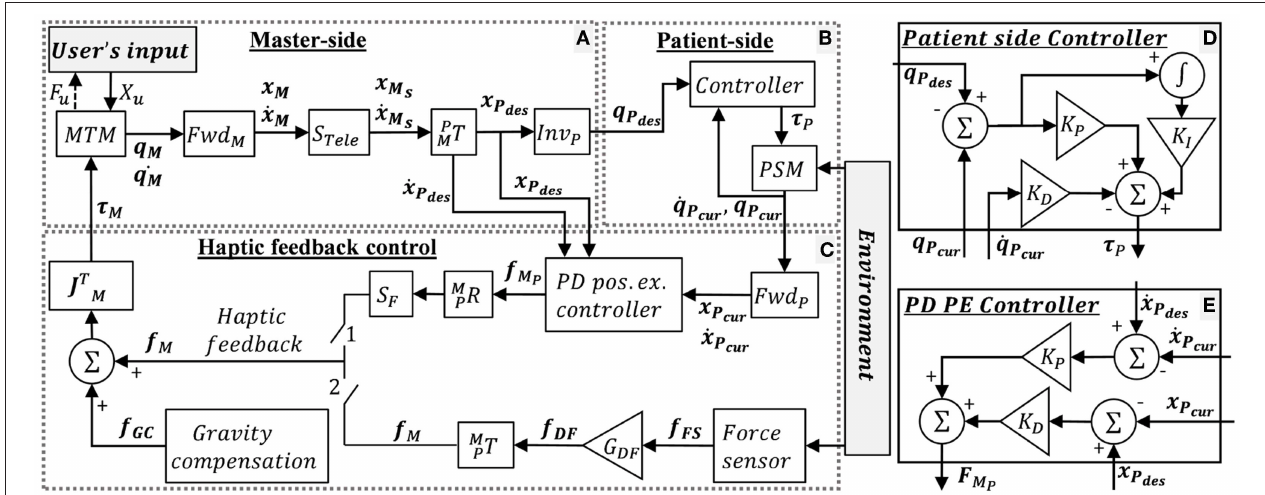
FIGURE 3 | dVRK teleoperation control. (A) Master-side, (B) patient side, and (C) haptic feedback conditions: when switch 1 is closed, the user receives position exchange (PE) haptic feedback. When switch 2 is closed, the user receives direct feedback (DF) haptic feedback. When both switches are open, the user does not